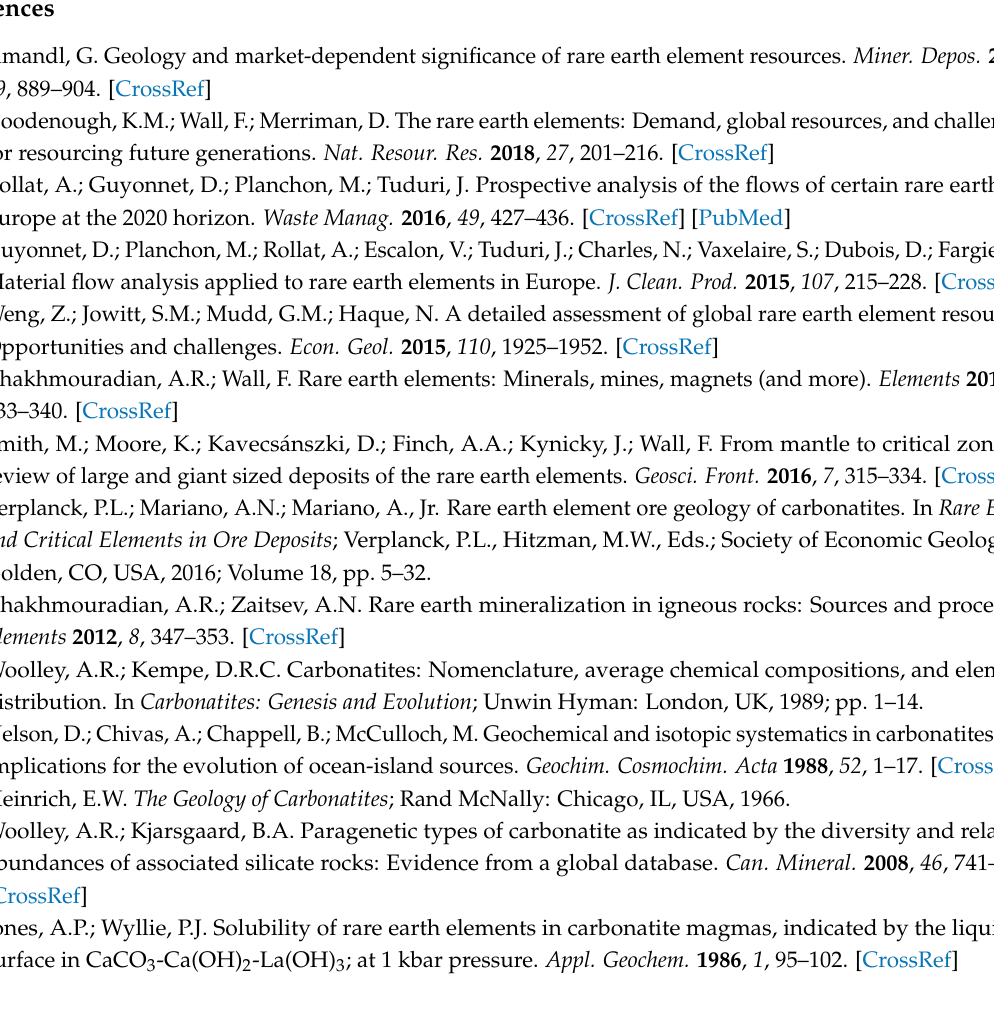
Table S1: Results for whole rock geochemical analyses. Table S2: Representative REE results in µ g/g for apatite, carbonates and barite by